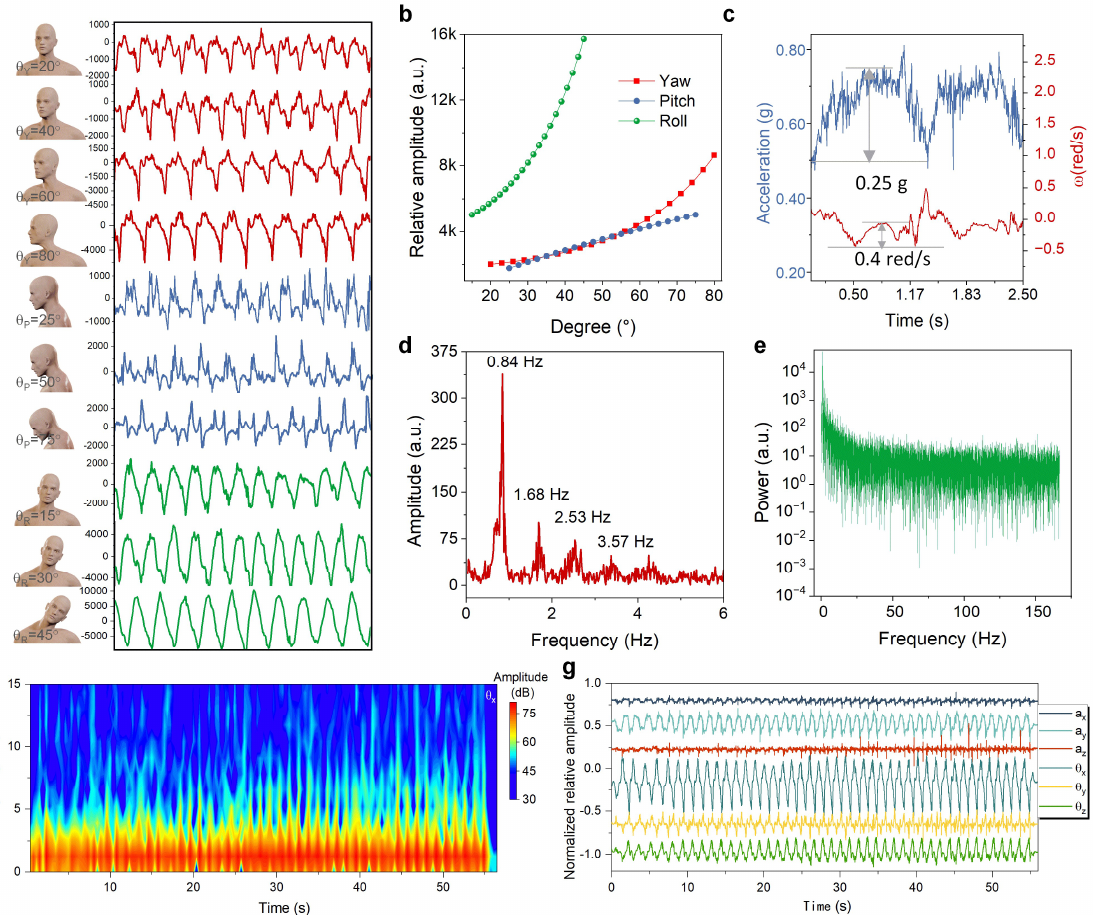
Figure 3. Inertial measurement results of head postures. ( a ) Continuous inertial angular velocity of the corresponding posture around the main axis. ( b ) Relative amplitude of head movements at different rotating angles. ( c ) The lowest resolution in the acceleration and angular velocity measurements when the pitch angle of the tested posture is 5 ◦ . ( d , e ) Frequency response of the amplitude and power spectrum of the head posture when θ Yaw = 80 ◦ , respectively. ( f ) Short-time FT result of the head posture around the main axis when θ Yaw = 80 ◦ . ( g ) Long-term inertial measured results of the head posture when θ Yaw = 80 ◦